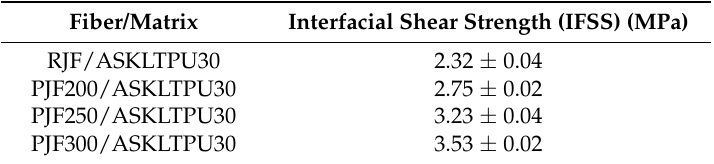
Table 1. Interfacial shear strength (IFSS) between JF and ASKLTPU30 measured from a single-fiber pull-out test.